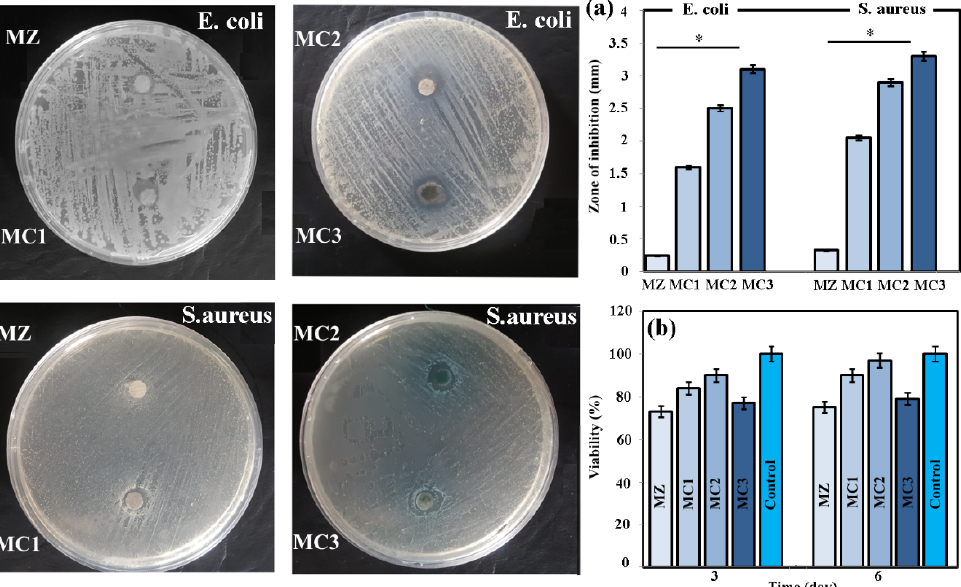
Figure 11. ( a ) Antibacterial activities by the disk diffusion test against both gram-positive ( S. aureus ) and gram-negative ( E. coli ) and ( b ) cell viability of MG63 cells cultured for various times on the MZ, MC1, MC2 and MC3 biocomposites.